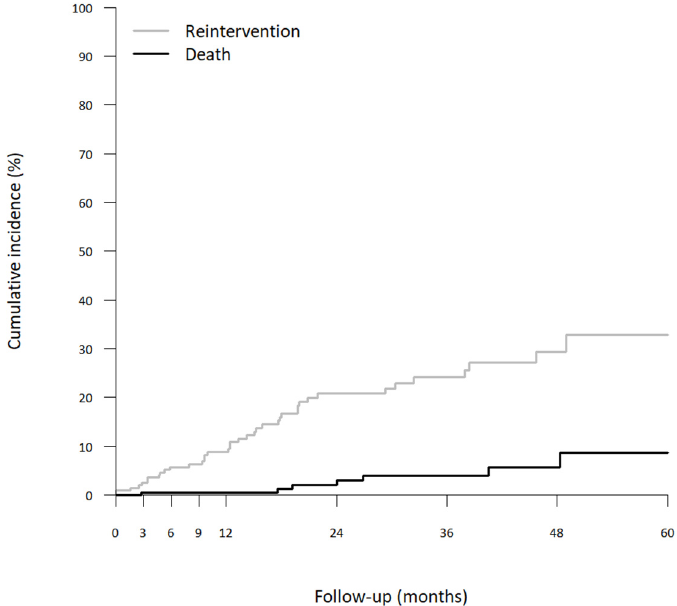
Figure 4. Cumulative incidence of reintervention using the time-to-event approach and considering the occurrence of death before reintervention as a competing event.